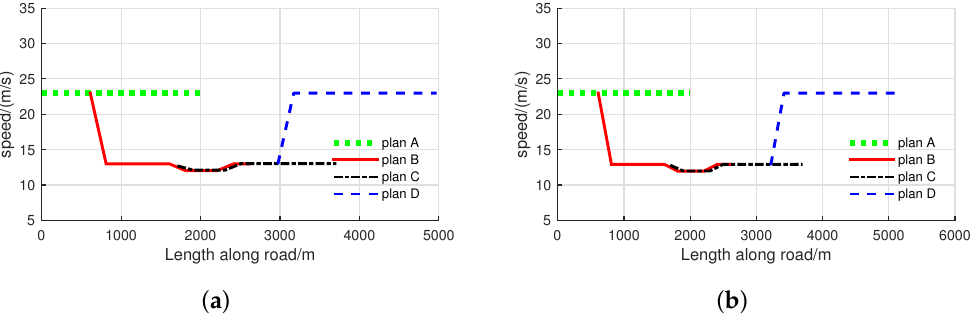
Figure 30. Piecewise speed plans: ( a ) Controller A + ISPFCE and ( b ) Controller B + ISPFCE.